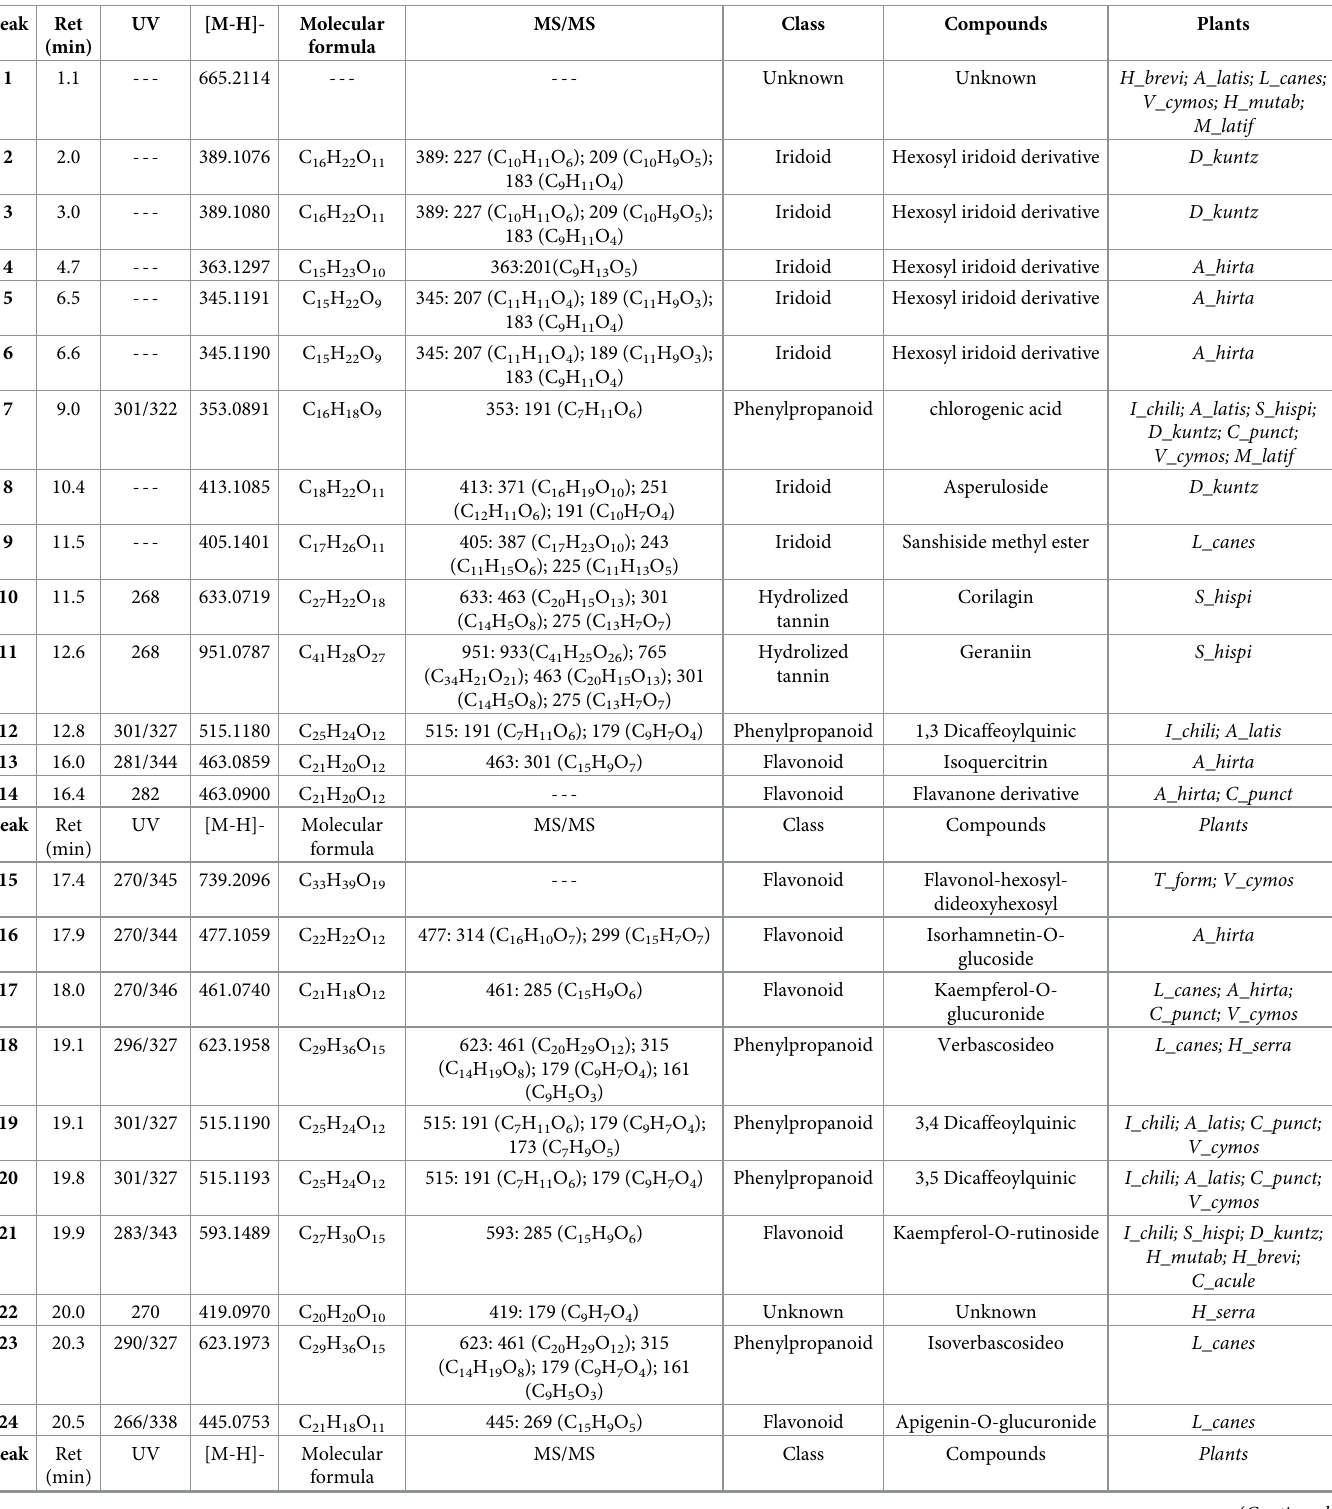
Table 4. Retention time, UV spectrum, mass, molecular formula, chemical class and plants species in which compounds were detected of active peaks with relative intensity of masses higher than 20000 and were positively correlated to EC 90 .